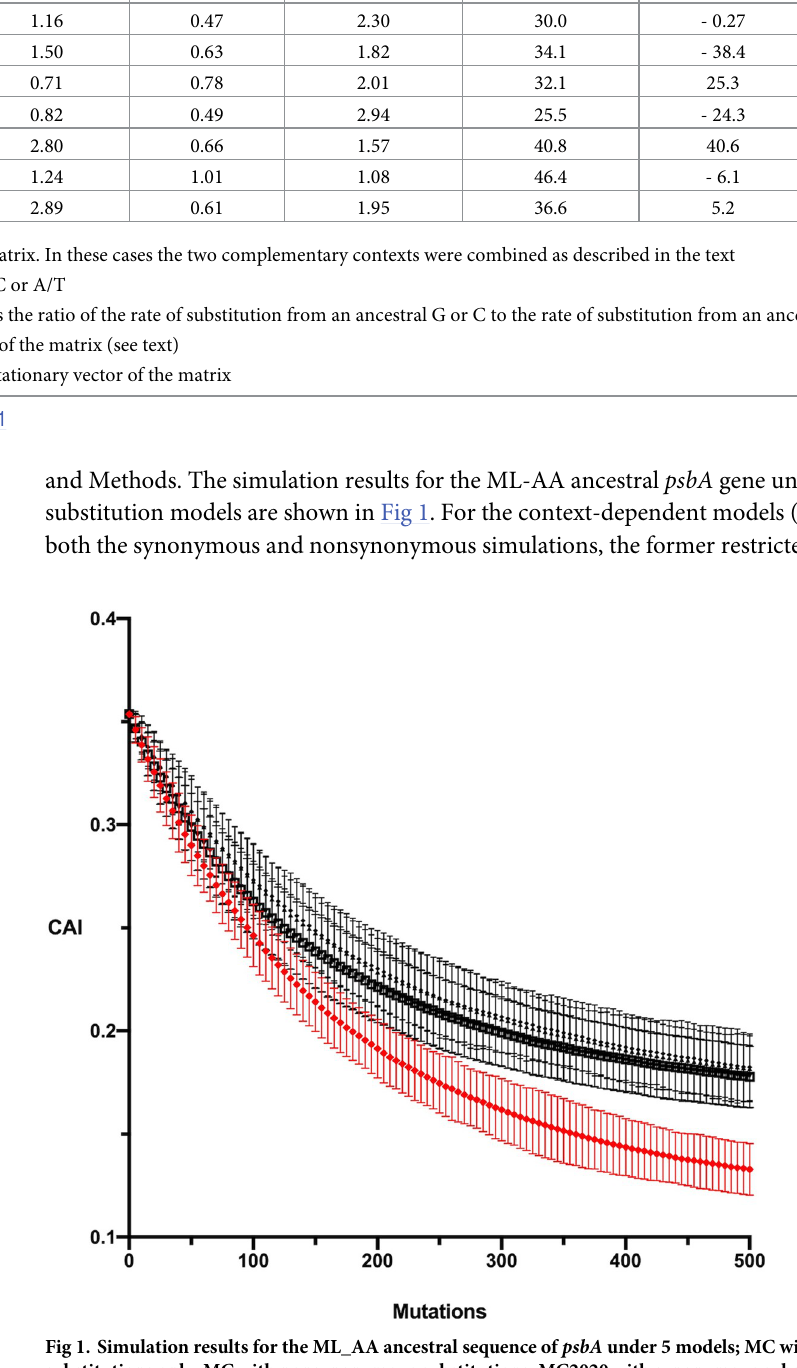
Fig 1. Simulation results for the ML_AA ancestral sequence of psbA under 5 models; MC with synonymous substitutions only, MC with nonsynonymous substitutions, MC2020 with synonymous substitutions only, MC2020 with nonsynonymous substitutions, and K2P with synonymous substitutions only. The four MC and MC2020 models are shown in black and the K2P model in